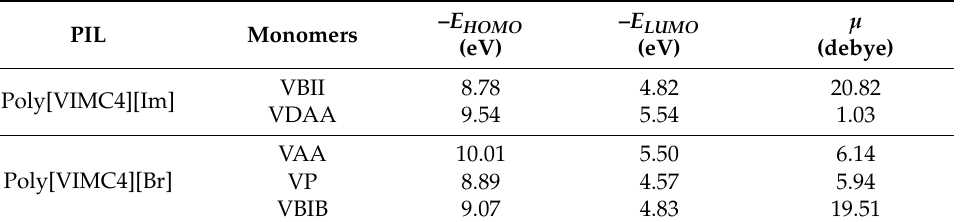
Table 8. Quantum parameters obtained from PIL monomers at B3LYP/6-311++ level in aqueous medium.